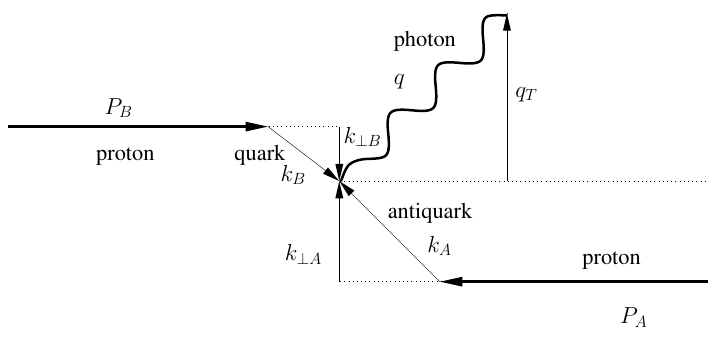
Figure 1 . Diagram describing the relevant momenta involved in a DY event. Two partons from two hadrons collide. They have transverse momenta k a virtual photon with (measured) transverse momentum q hadron collision